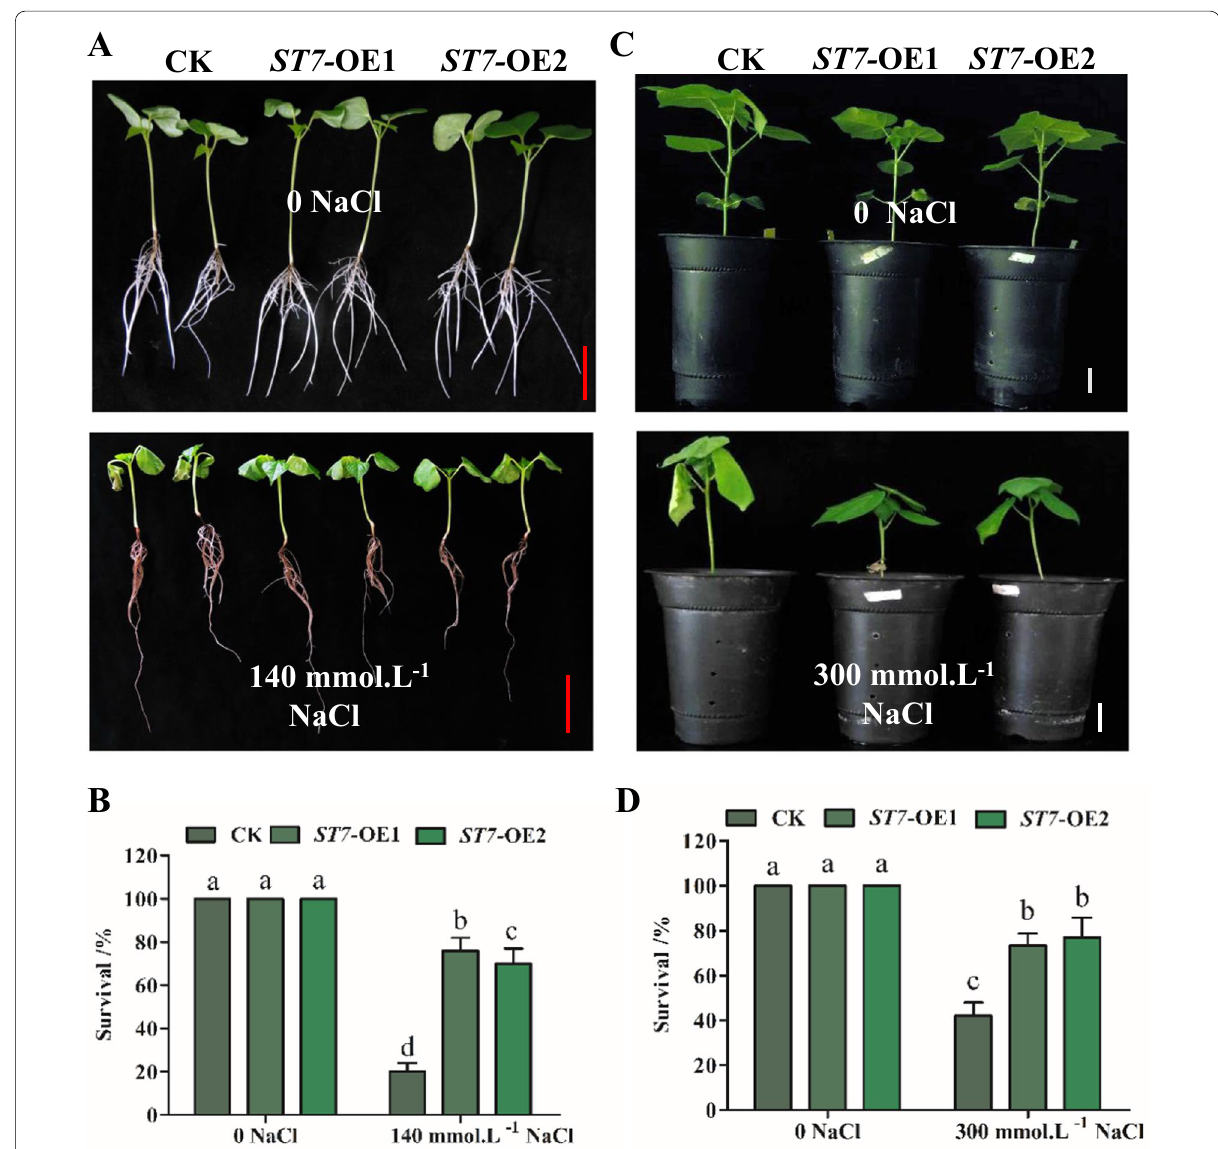
Fig. 2 ThST7 overexpression improved salt tolerance of 2-weeks-old cotton seedlings grown in hydroponic culture or in soil under different salt concentrations. A , B Seeds of the CK and ST7 -OE lines germinated in soil for 4 days, transferred to hydroponic culture for 1 week and then treated with 140 mmol L − 1 NaCl for 3 days. Bar 4 cm. Values are mean SD (7 plants per replicate, four replicates per treatment). Different letters · = ± denote significant differences ( P < 0.05) from Duncan’s multiple range tests. C The 20-days-old seedlings grown in soil were treated with either 0 or 300 mmol L − 1 NaCl for 10 days before the images were recorded. Bar 4 cm. D Survival rate of the seedlings as in C . Values are mean · = plants per replicate, five replicates per treatment). Different letters denote significant differences ( P < 0.05) from Duncan’s multiple range